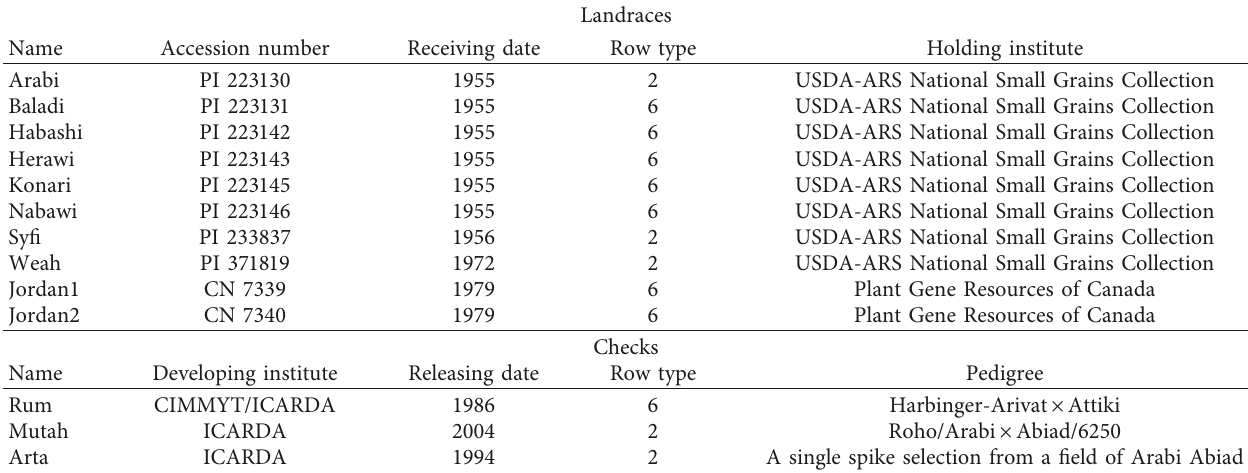
Table 1: Name and origin of barley genotypes used in this